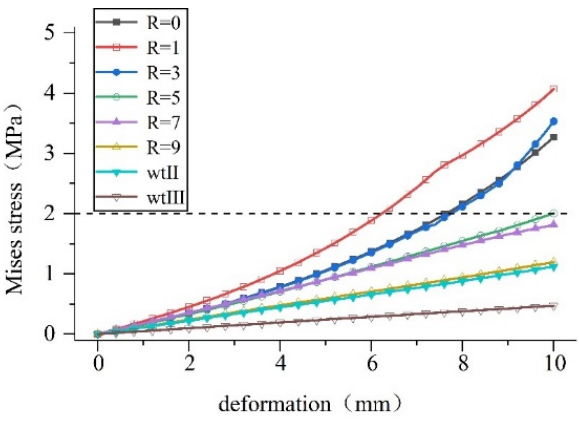
Figure 20. Compression deformation stress on waterstops of various size.